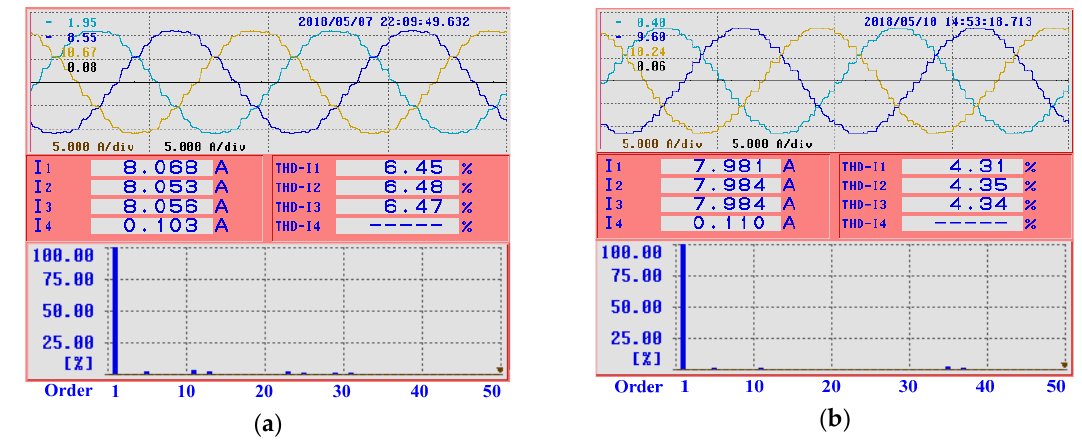
Figure 10. Input line currents and their spectrums. ( a ) When the unconventional IPR operating as double-tapped IPR. ( b ) When the unconventional IPR with the optimal parameters.